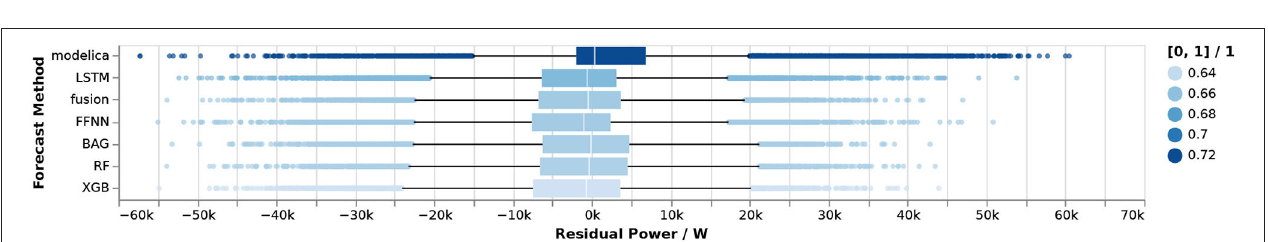
FIGURE 7 | Forecasts and measurements for 2019-06-26 to 2019-06-28: physics-based, LSTM, and FFNN (A) as well as BAG, RF, XGB, and fusion (B) .